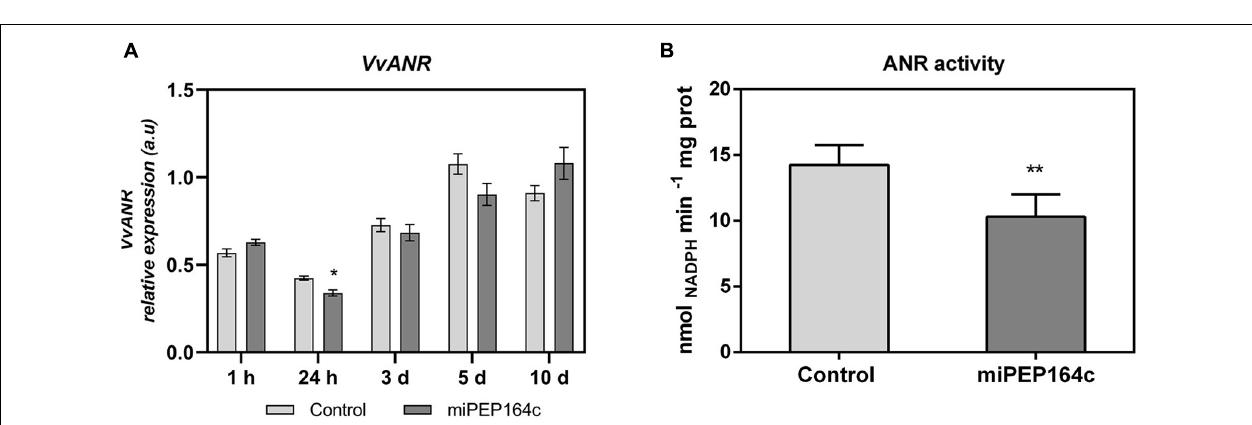
FIGURE 3 | Steady-state transcript levels of VvLAR1 in suspension-cultured grape berry cells (cv. Gamay) 10-day after elicitation with various concentrations of miPEP164c (A) and the effect on the specific activity of leucoanthocyanidin reductase (LAR) (B) in suspension-cultured grape berry cells (cv. Gamay) after 10 days of elicitation with 1 µ M miPEP164c. Gene expression analysis, by real-time qPCR was normalized with the expression of reference gene VvACT1 and VvGAPDH . Values are the mean ± SEM. Asterisks indicate statistical significance in relation to the control (Student’s t -test; * P < 0.05). LAR biochemical activity represented as the V max in grape berry cells under miPEP164c treatment. Values are the mean ± SEM. Asterisks indicates statistical significance (Student’s t -test; *** P < 0.001).